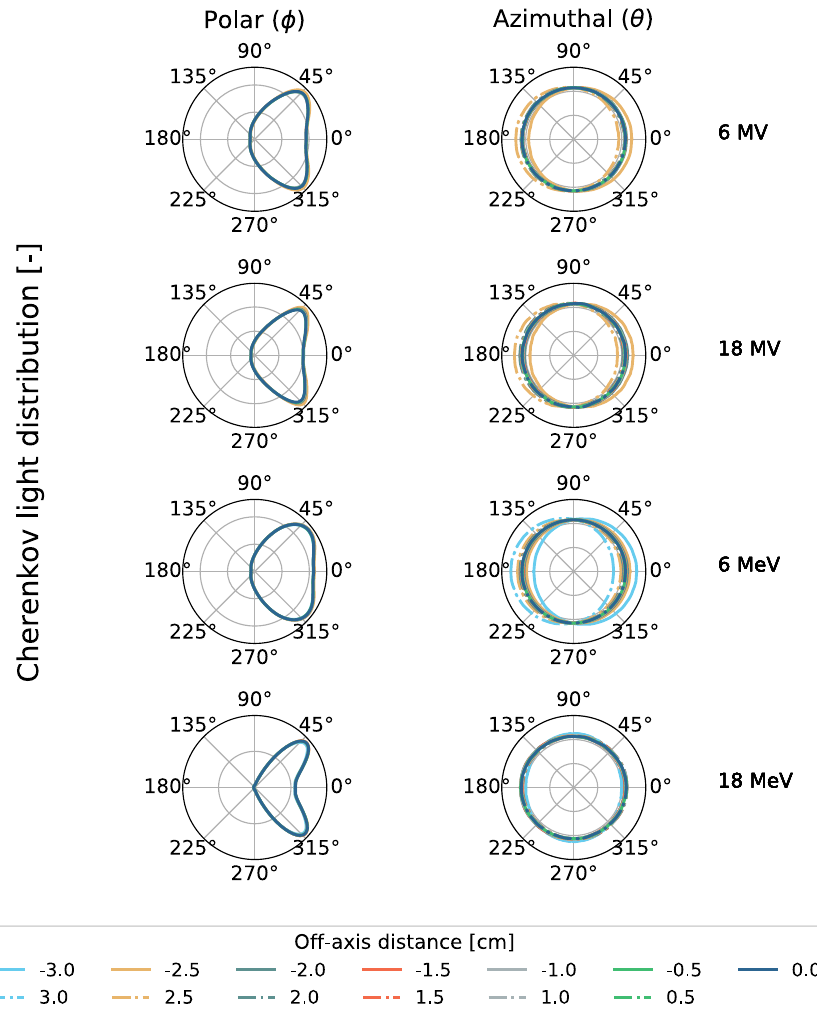
Figure 2. Cherenkov signal polar and azimuthal distributions extracted from different off-axis positions at the depth of maximum dose ( d max ). The distributions were acquired from 6 MV , 18 MV , 6 MeV and 18 MeV beams. ± 3 cm curves are not plotted for photon beams as these positions are larger than the beam